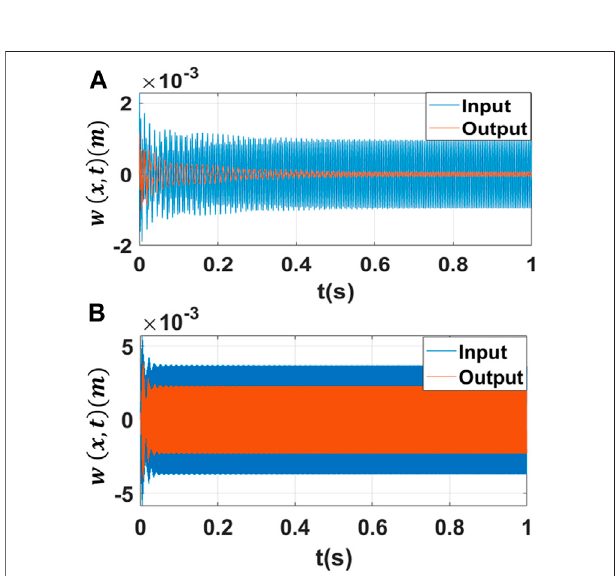
FIGURE 8 | Model simulations of displacement response of the local resonators at the topmost beam and the lowest beam within the two main frequency bandgaps: (A) within the fi rst bandgap at the unit cell ’ s resonant frequency, F n (cid:1) 224Hz, (B) within the second bandgap, F (cid:1)